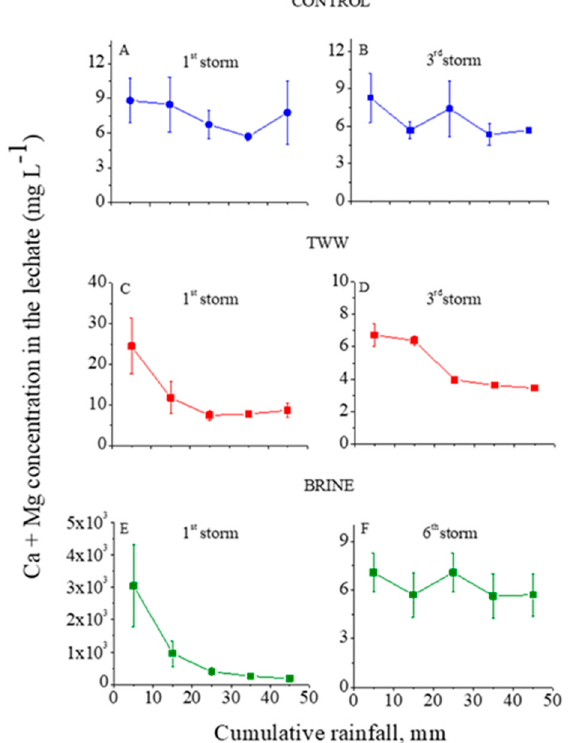
Figure 3. Ca+Mg concentrations in the outflow leachate from the trays with treated granular materials as functions of the cumulative rainfall of the 1st ( A ) and 3rd ( B ) consecutive rainstorms for the control, of the 1st ( C ) and 3rd ( D ) consecutive rainstorms for the treated wastewater (TWW) treatment, and of the 1st ( E ) and 6th ( F ) consecutive rainstorms for the brine treatment. Vertical lines near the symbols are standard deviations (the Y-axes’ scales are different).